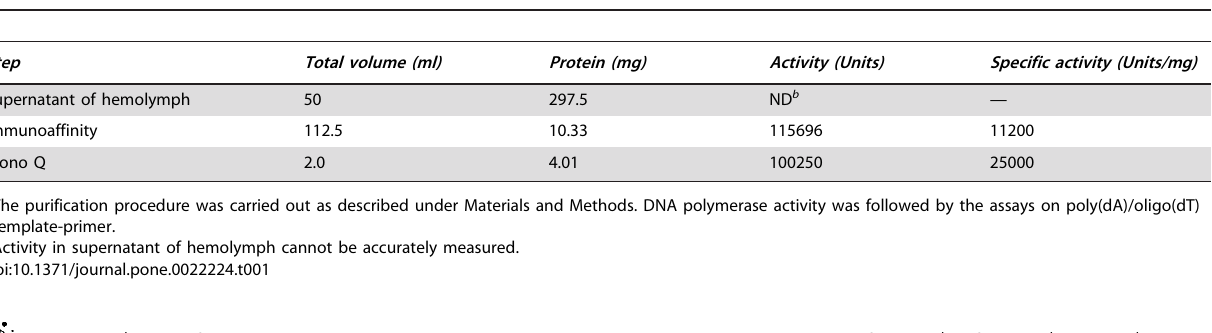
Table 1. Purification of recombinant DNA polymerase d from infected silkworm larvae a